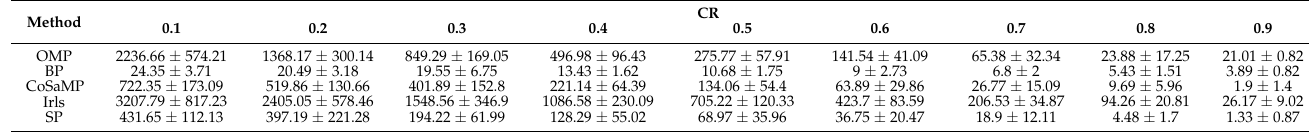
Table 3. Execution times (in seconds) of various reconstruction algorithms. Values are mean ± SD.